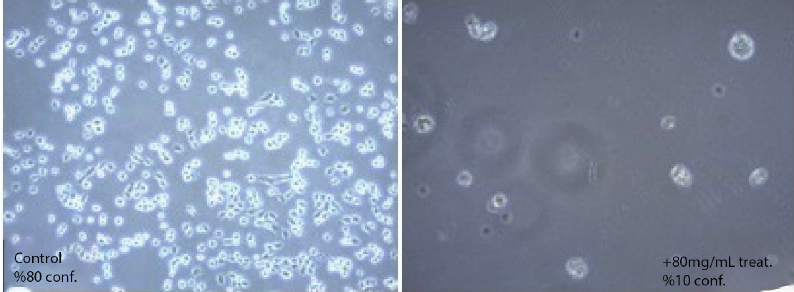
Figure 2 - The role of P. russeliana on human colon cancer cells by morphological manner. Cells were compared untreated with 80mg/ml of P. russeliana (captured from T-25 flask). The difference growth rate log phase between %80-%10 confluency. (displayed inverted microscope x100).